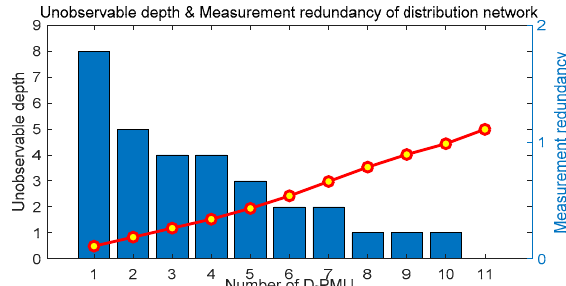
Figure 11. Unobservable depth and measurement redundancy of the IEEE 33 bus system.